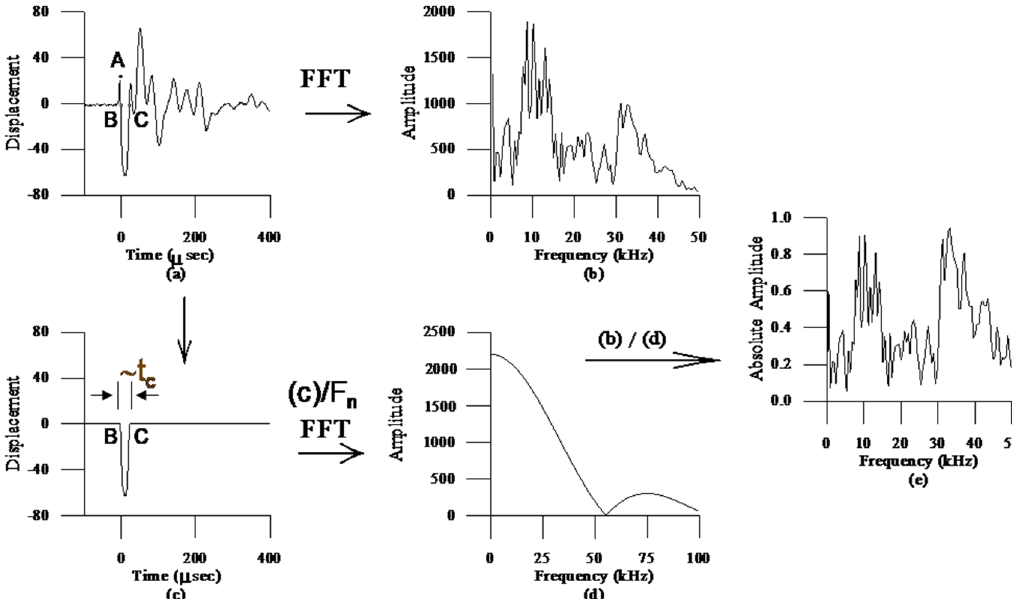
Figure 3. Procedure to obtain the normalized IE spectrum. ( a ) IE displacement waveform; ( b ) IE amplitude spectrum, ( c ) R-wave displacement waveform; ( d ) Amplitude spectrum of R-wave; ( e ) normalized amplitude spectrum.